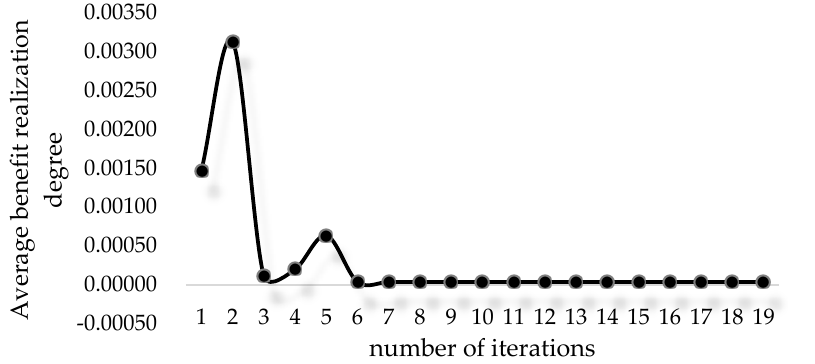
Figure 6. Update on the variance of the degree of interest.